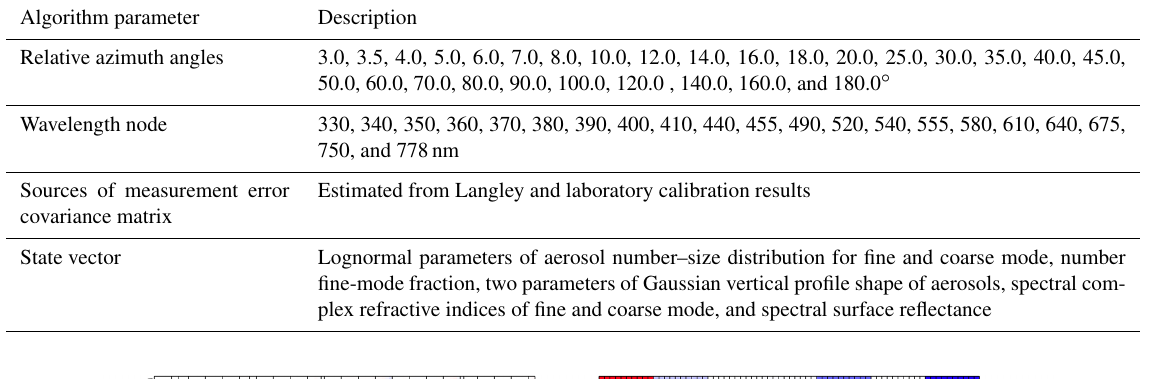
Table C1. Relative azimuth angles, wavelength node, sources of measurement error covariance matrix, and parameters of state vector of SMART–s algorithm.